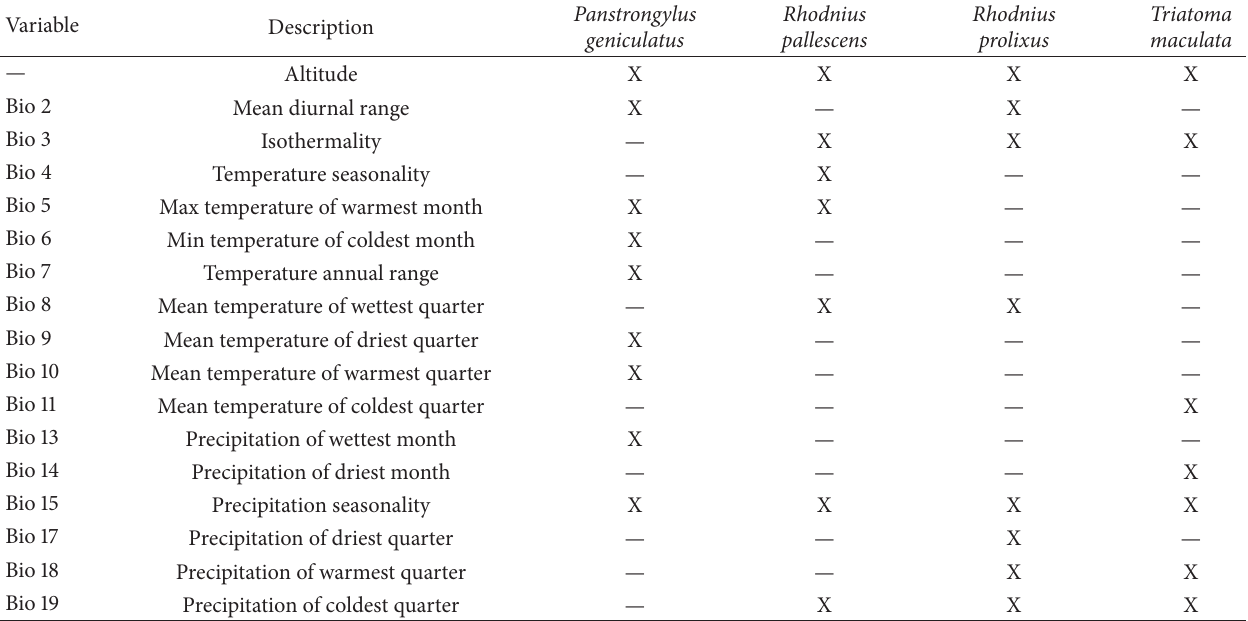
Table 1: Uncorrelated ( 𝑟 𝑝 < 0.7) environmental variables used in the species distribution models for the triatomine species. Variable